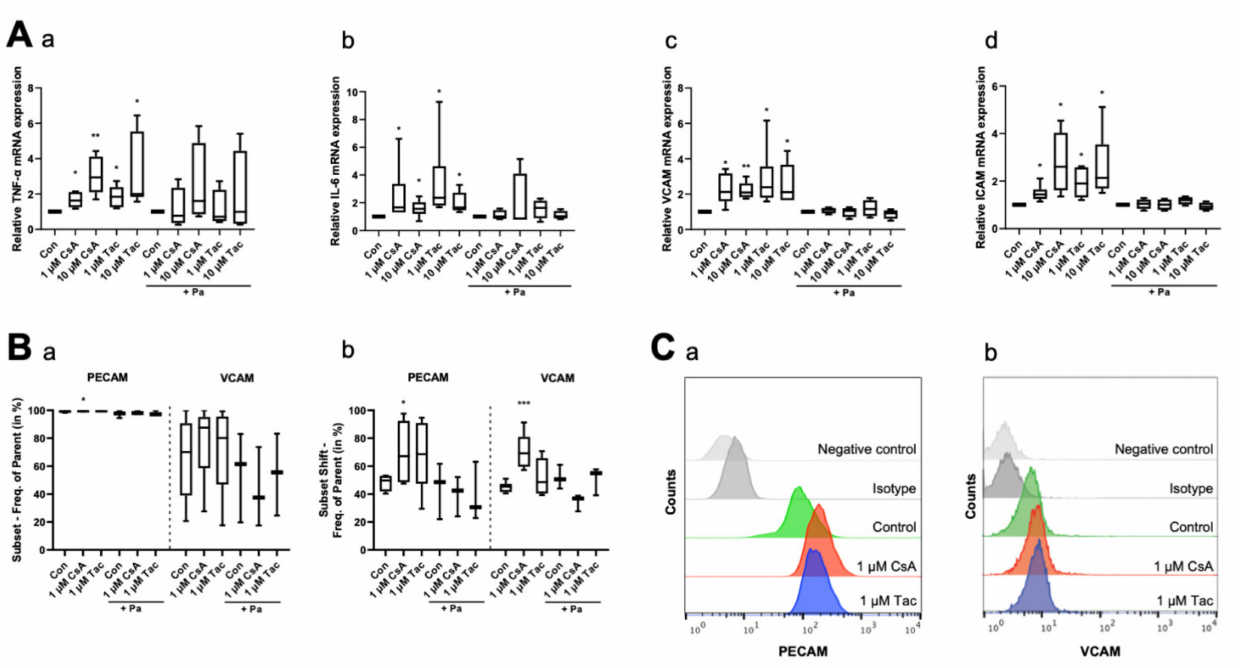
Figure 4. Cyclosporine A (CsA) and tacrolimus (Tac) increased mRNA and cell surface expression of inflammatory cytokines and adhesion molecules in ECFCs. ( A ) CsA and Tac (1 or 10 µ M) significantly induced mRNA expression of the inflammatory cytokines TNF- α (a) and IL-6 (b) and of the adhesion molecules VCAM (c) and ICAM (d). Parthenolide (Pa), an NF- κ B inhibitor, reduced the CsA- and Tac-induced effects. All runs were performed in triplicates. Control group set as 1, n = 4–6. In flow cytometry ( B ), treatment with 1 µ M CsA significantly increased PECAM and VCAM cell surface expression (a) and shift (b), treatment with 1 µ M Tac only showed a slight increase. Pa moderated the CsA- and Tac-induced effects, n = 3–6. ( C ) Representative measurement of PECAM (a) and VCAM (b) surface expression after treatment with 1 µ M